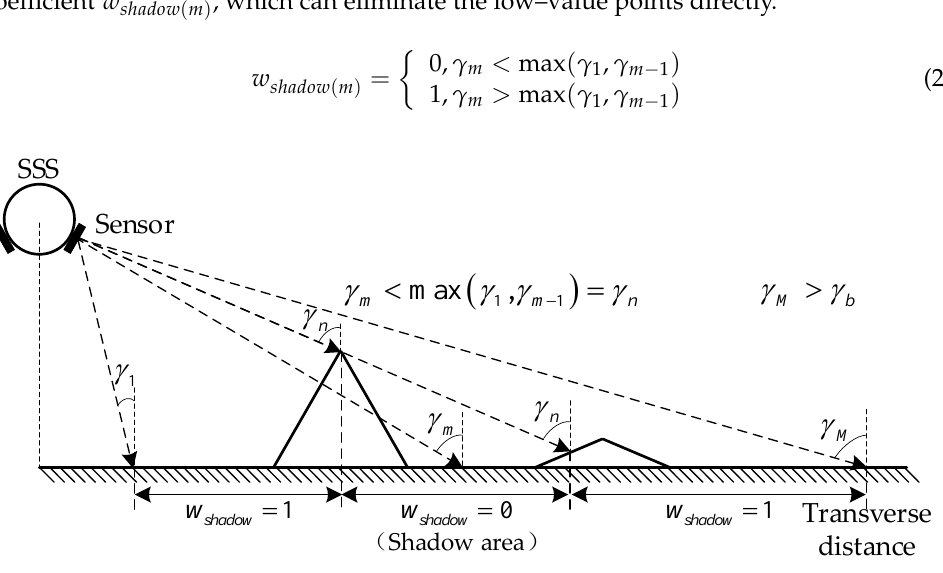
Figure 13. Geometric model for calculating shadow coefficient.